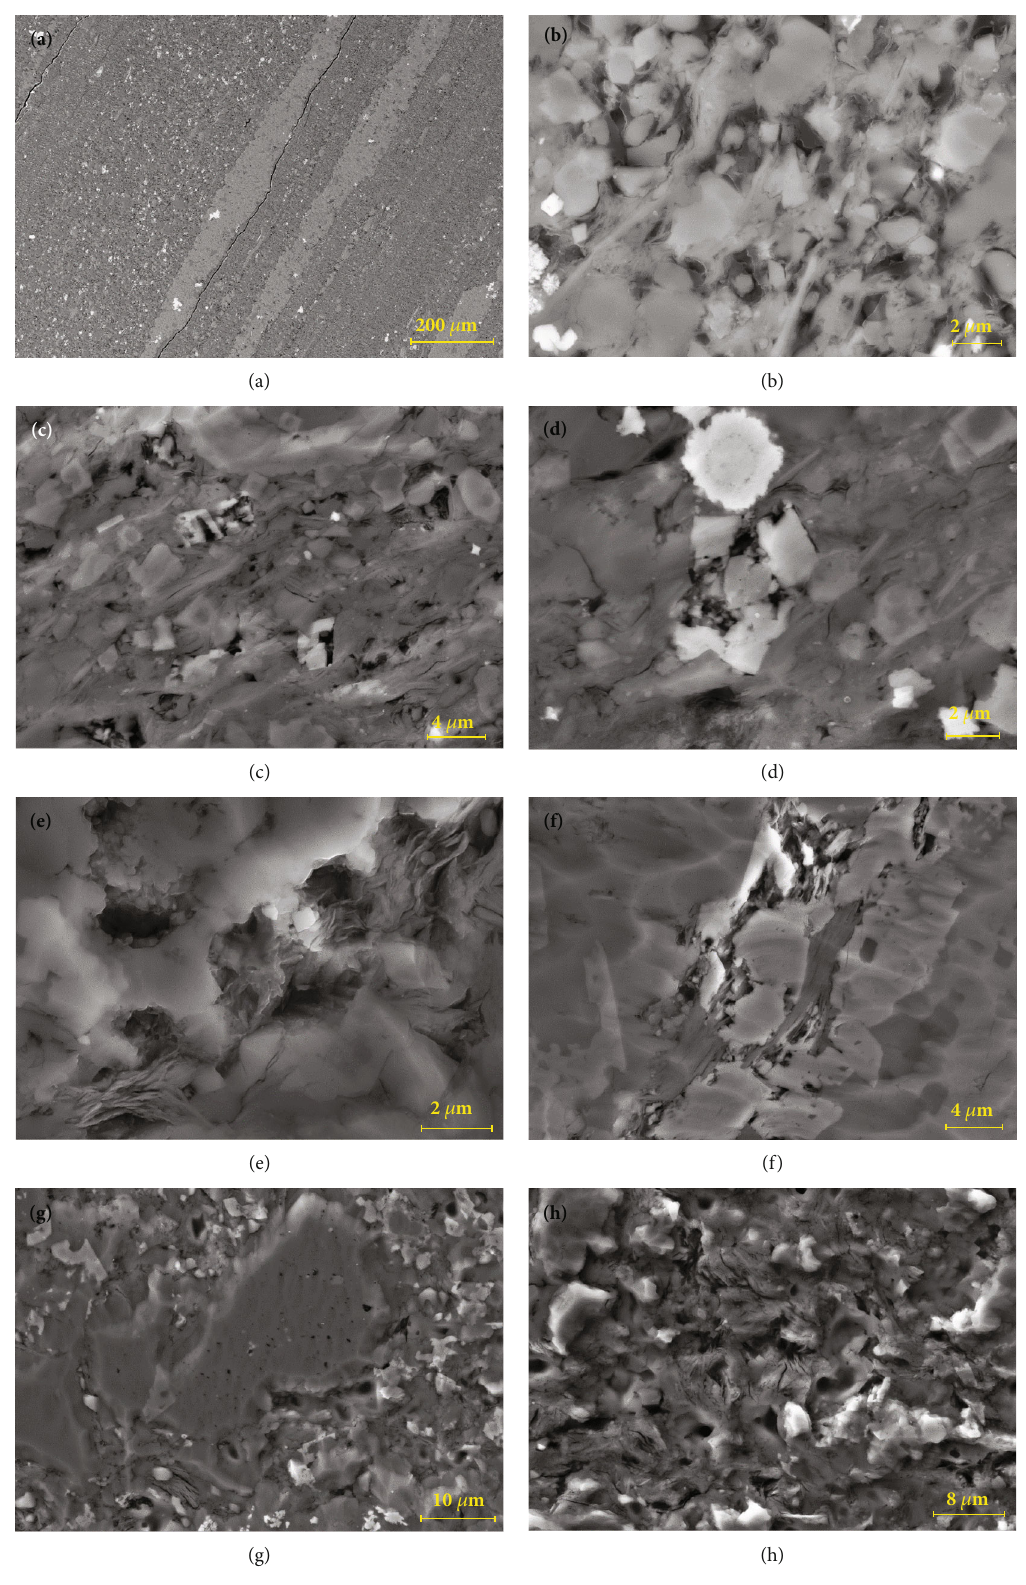
Figure 8: FE-SEM images of samples from the Dongying Depression: (a) calcite laminae and fractures; (b) organic pores; (c) intergranular pores; (d) intercrystalline pores of clay minerals; (e) dolomite dissolution pore; (f) dissolution and organic pores; (g) intragranular pores; and (h) intergranular